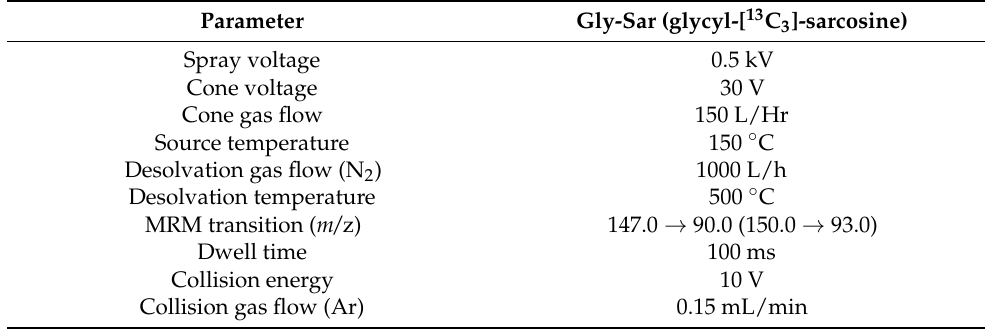
Table 1. Optimized parameters for the MS/MS detection of glycyl-sarcosine and glycyl-[ 13 C 3 ]- sarcosine in positive heated ESI and